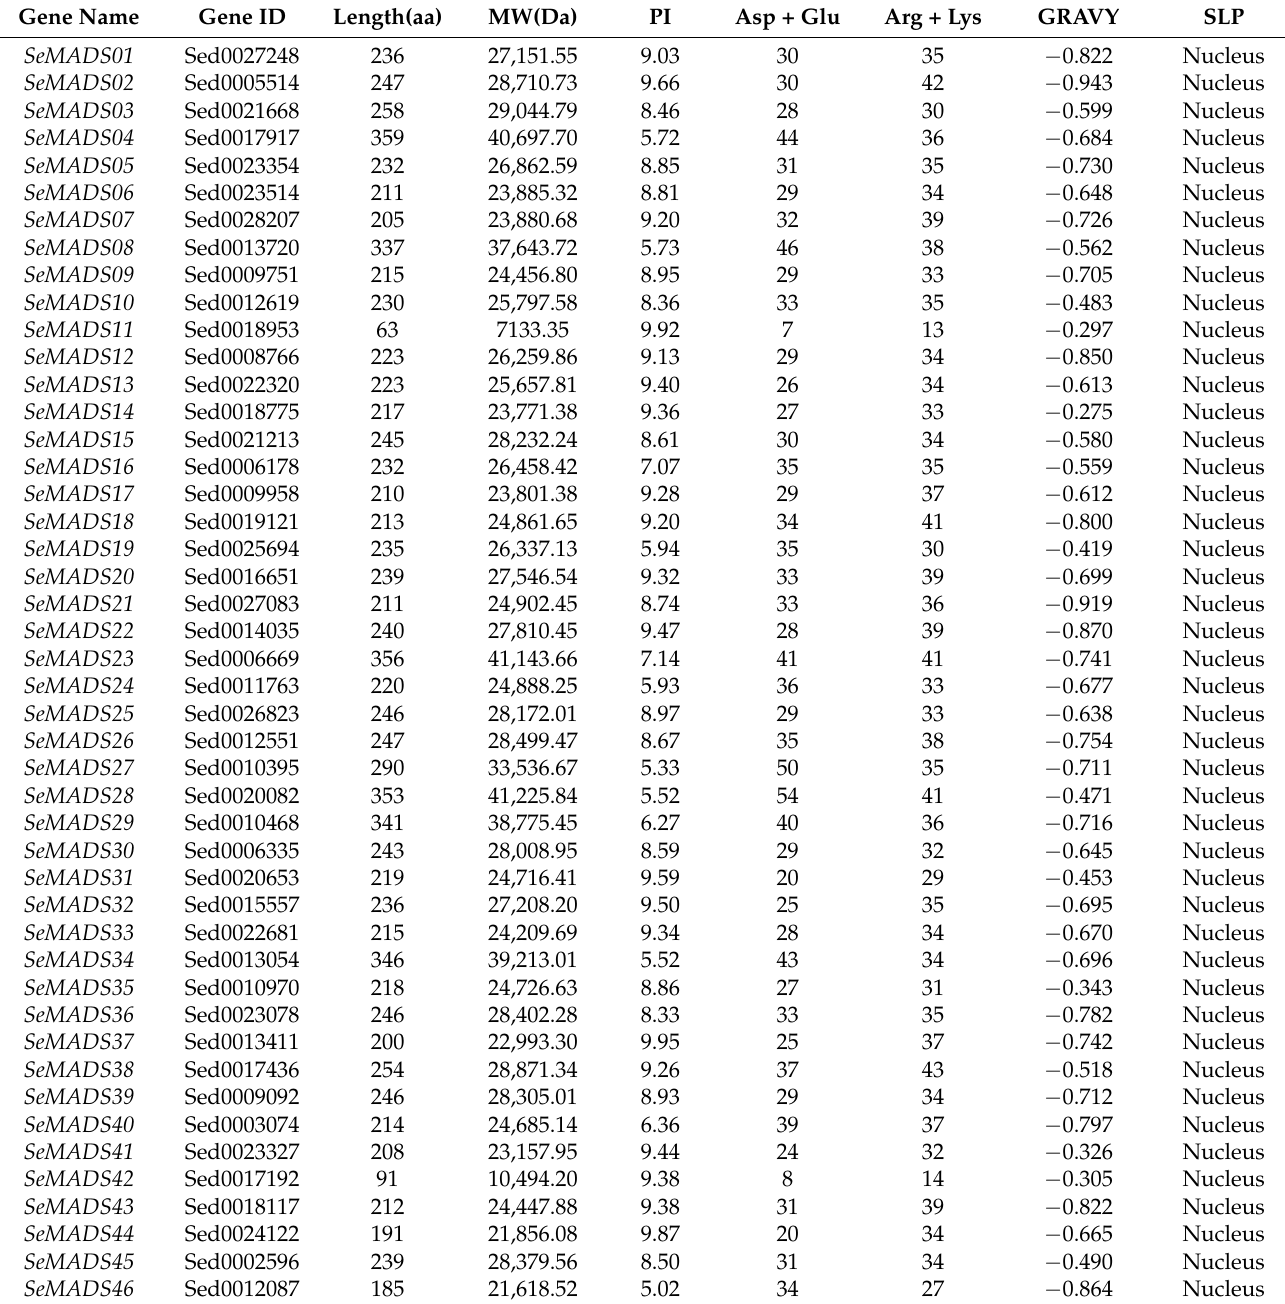
Table 1. Physical and chemical properties of MADS-box genes family in S. edule . (MW: molecular weight; PI: isoelectric point; ASP + Glu: total number of negatively charged residues (ASP + Glu); Arg + Lys: total number of positively charged residues (Arg + Lys); GRAVY: Grand average of hydropathicity; SLP: subcellular localization